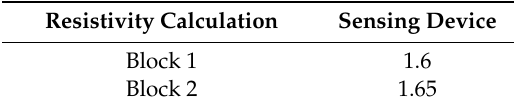
Table 6. Experiment 2 chloride calculation results in M.